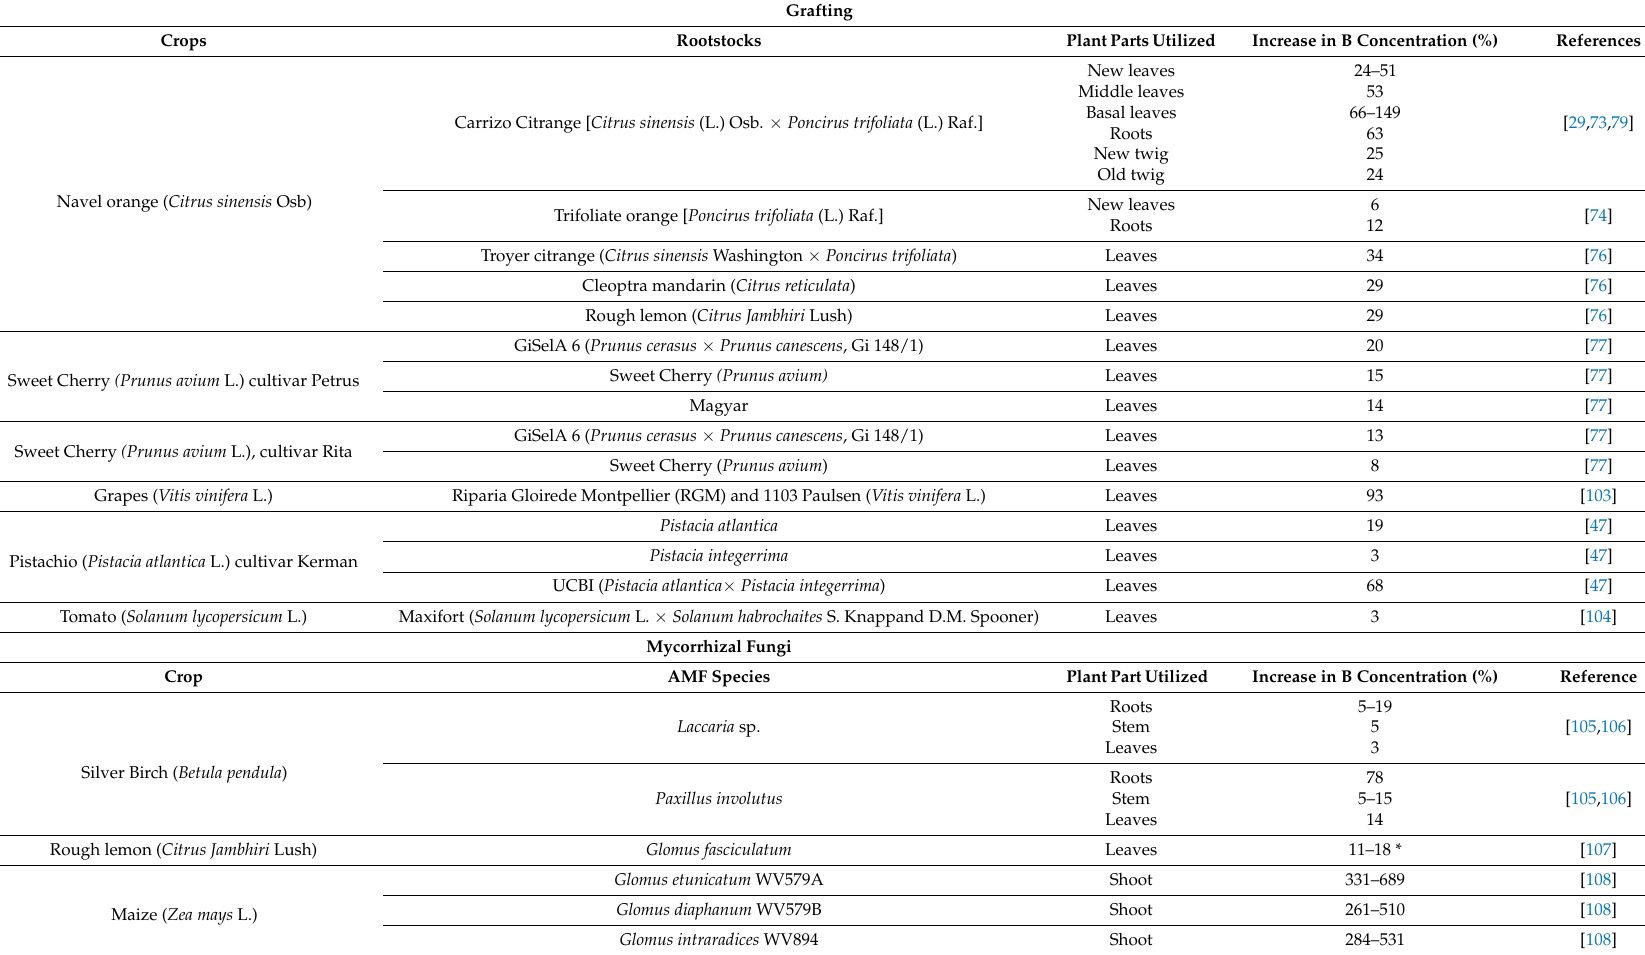
Table 1. Influence of grafting and mycorrhizal fungi on B uptake of plants.